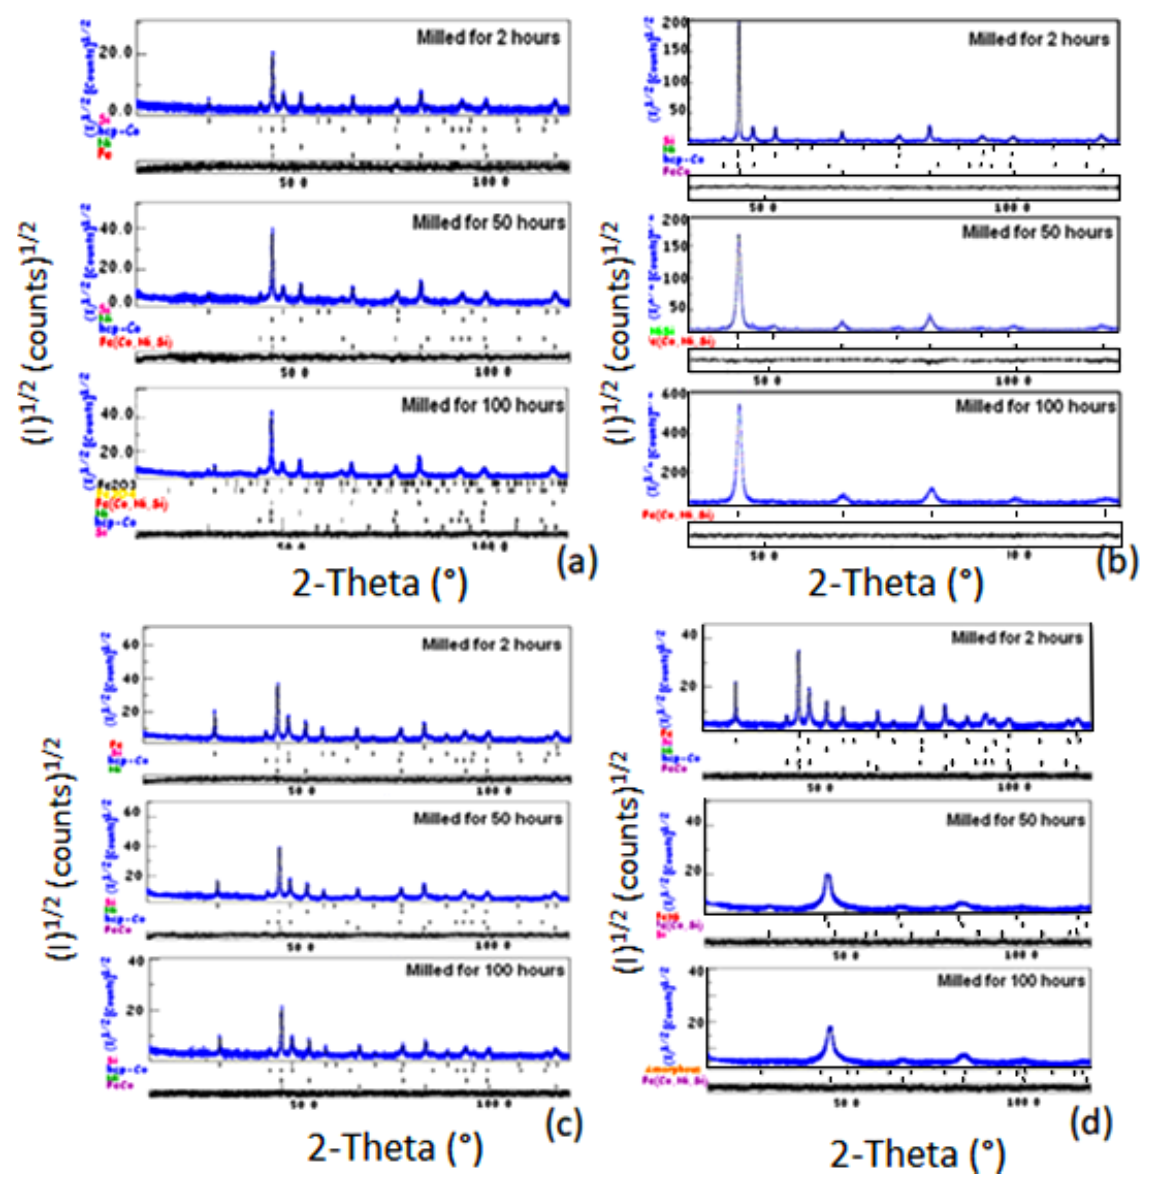
Figure 3. XRD diffractograms (experimental, refinement) of powdered mixtures containing 5 ( a ), 10 ( b ), 20 ( c ), and 30 ( d ) at.% Si. Alloys are milled for 2, 50, and 100 h.